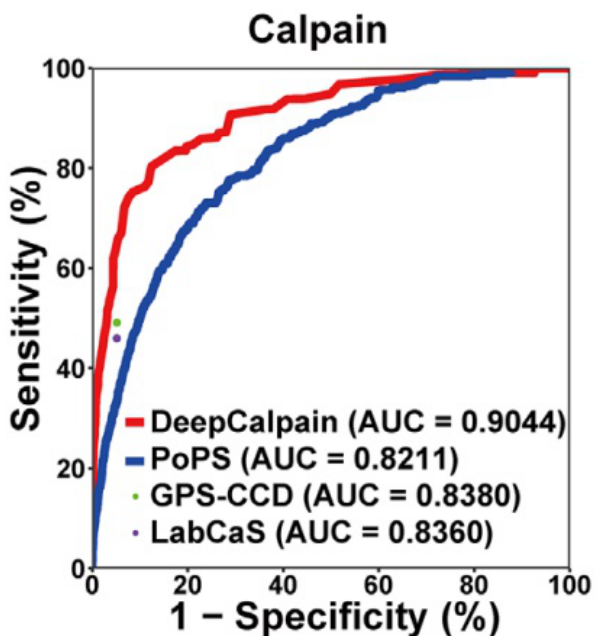
Figure 4. DeepCalpain compared with similar protease prediction programs according to AUC. This figure is reproduced with permission from reference [72], accessed on 2 February 2022. Copyright © 2019 Liu, Yu, Dong, Zhao, Liu, Zhang, Li, Du and